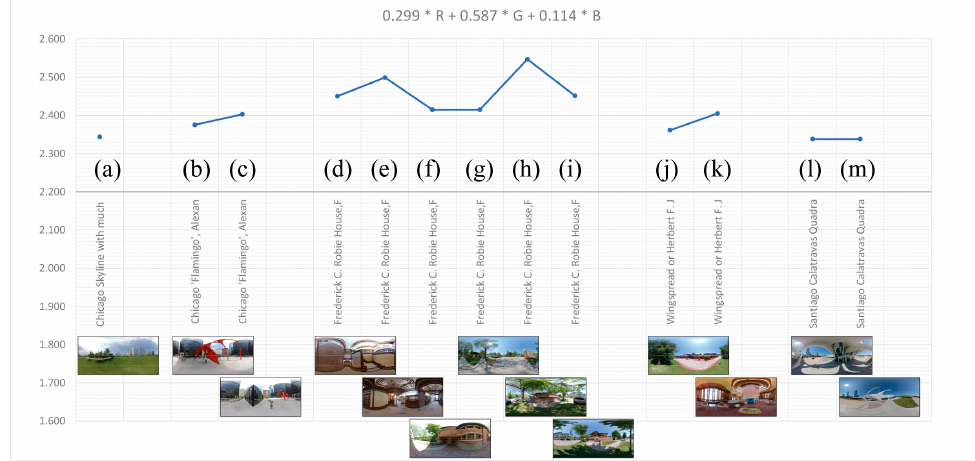
Figure 12. Measurement method “Grayscale DBX M × N ( m × m ) (shifting boxes)” with the weighted grayscale conversion adapted to the perception of brightness (see Formula (13)) applied to di ff erent spherical